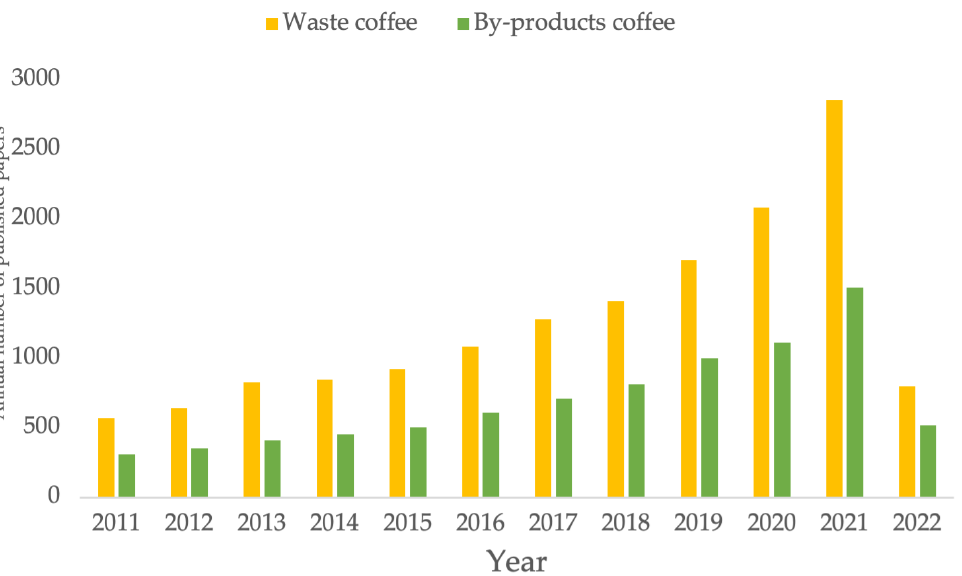
Figure 4. Annual number of published papers related to coffee wastes and by-products (source: Web of Science, accessed on 5th of September 2022).